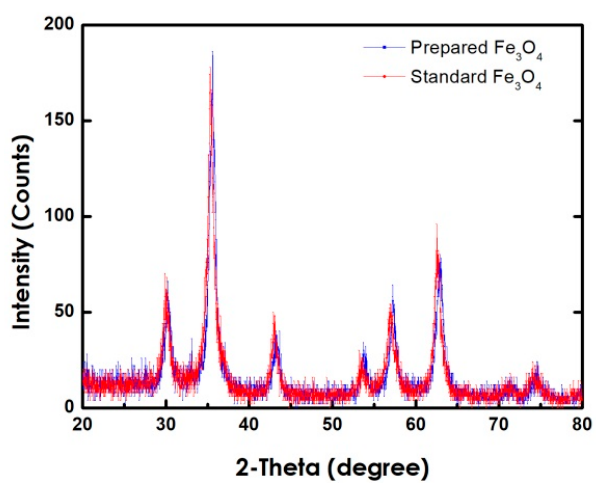
Figure 12. Comparison between the prepared and standard Fe 3 O 4 .